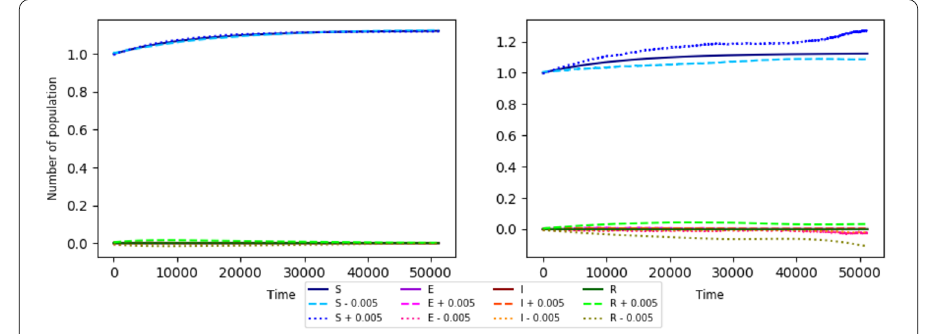
Figure 3 Stability modeled using the parameters N = 1, β = 0.8, σ = 0.3, μ = 0.08, η = 0.09, and (a) γ = 0.85 and υ = 0.7 (right), (b) γ = 0.75 and υ = 0.7 (left). The initial condition is ( N ,0,0,0) = (1,0,0,0) for all of